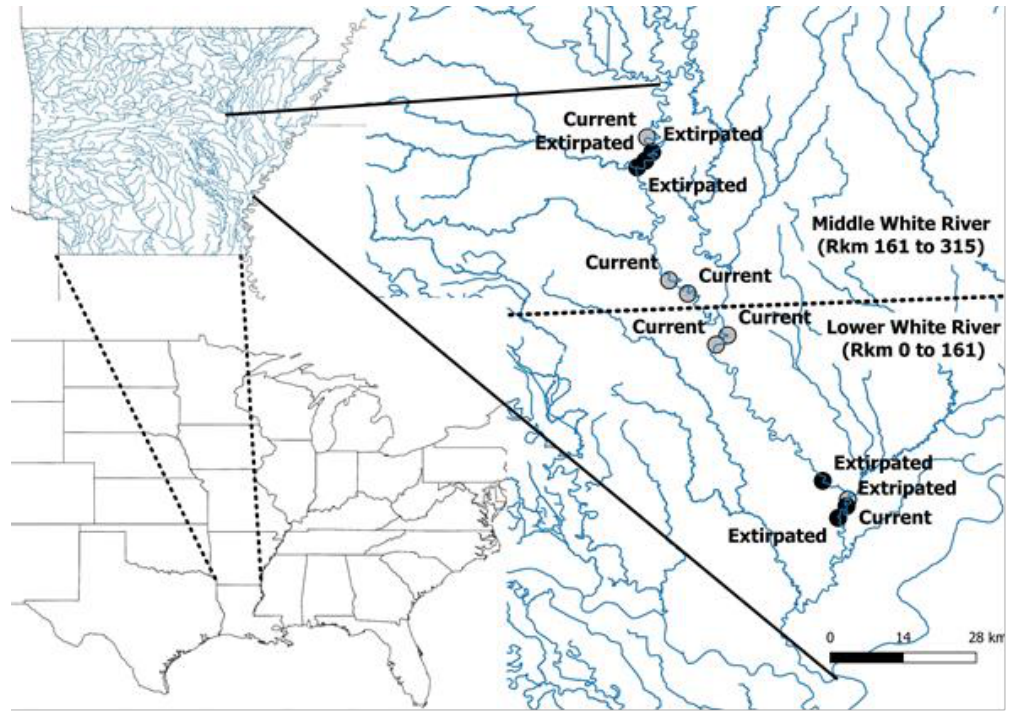
Figure 3. Map of the lower portion of the White River, AR, USA, displaying the Middle and Lower White River demarcation (solid bar) and sampling locations (gray filled circles = Current; black filled circles = Extirpated) Top of study area is near Georgetown, AR, USA (35.126619° N; −91.447014° W) and the bottom of the White River on this map is near Arkansas Post, AR, USA (34.017883° N; −91.185636° W) . Illustration created by A.D.C.